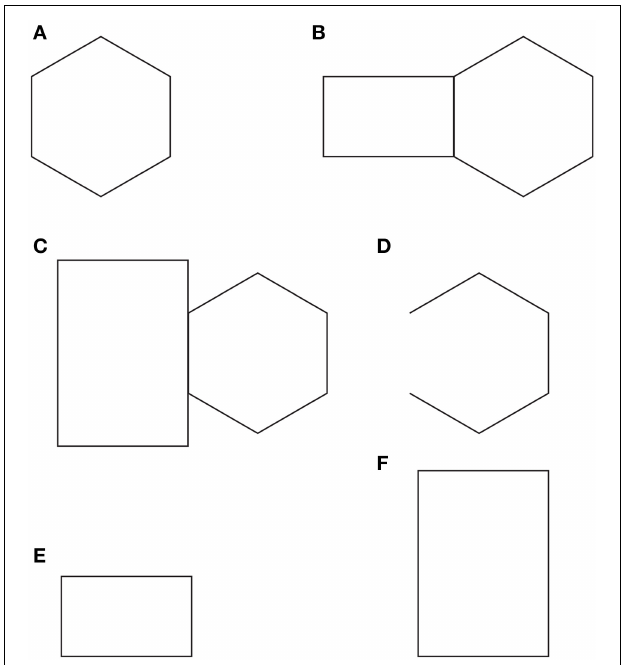
FIGURE 10 | Tessellation, occlusion and other sources of directional organization. For further details please see the text.